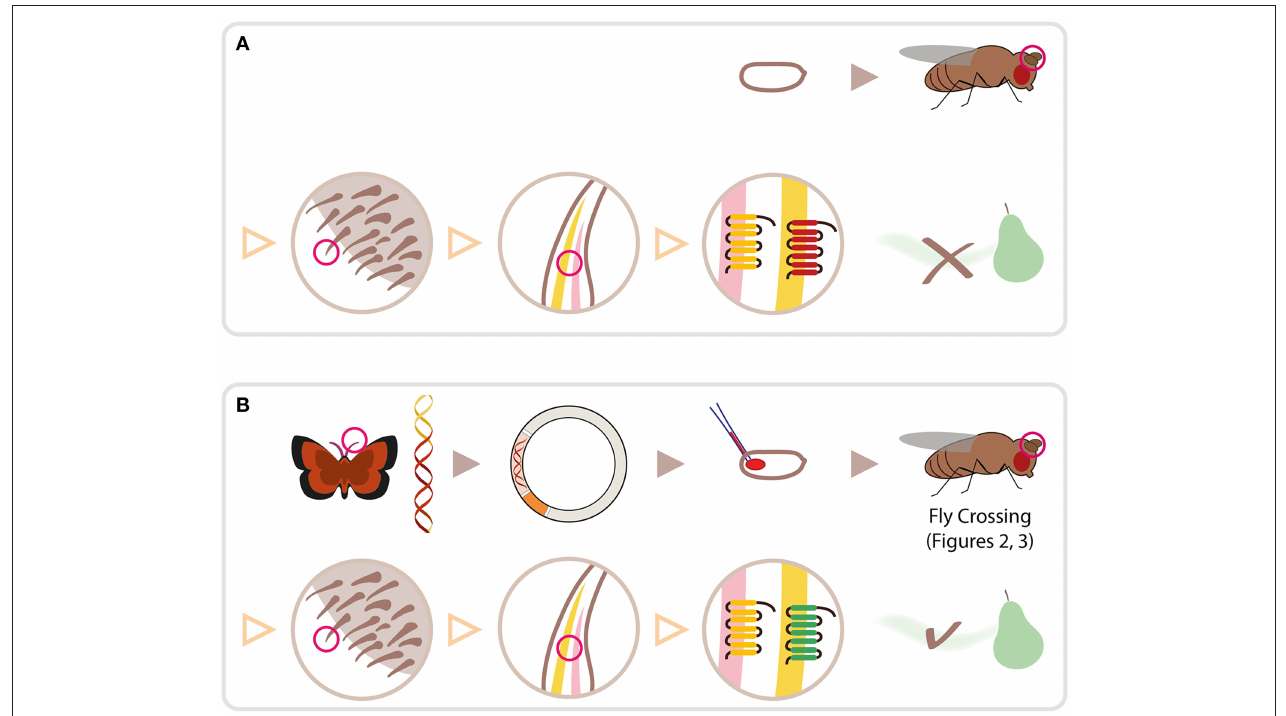
FIGURE 1 | Schematic overview for heterologous expression of insect ORs in Drosophila OSNs. (A) Wild type fly embryo and fly (top row). Red circle highlights antenna, shown in three magnification steps (second row, separated by triangles): sensilla on antenna; 2 olfactory sensory neurons (OSNs) housed in one sensillum; olfactory receptor proteins (ORs) expressed in cell membrane of each OSN. Wild type flies do not smell pear ester. (B) cDNA is synthesized from RNA extracted from lepidopteran antennae; OR gene is cloned into plasmid; plasmid is injected into fly embryo. Following crosses using Gal4/UAS expression system, lepidopteran OR tuned to pear ester is expressed in target OSN on fly antenna, allowing it to detect pear ester. Moth and fly drawing by Katarina Eriksson (www.markadesign.se).